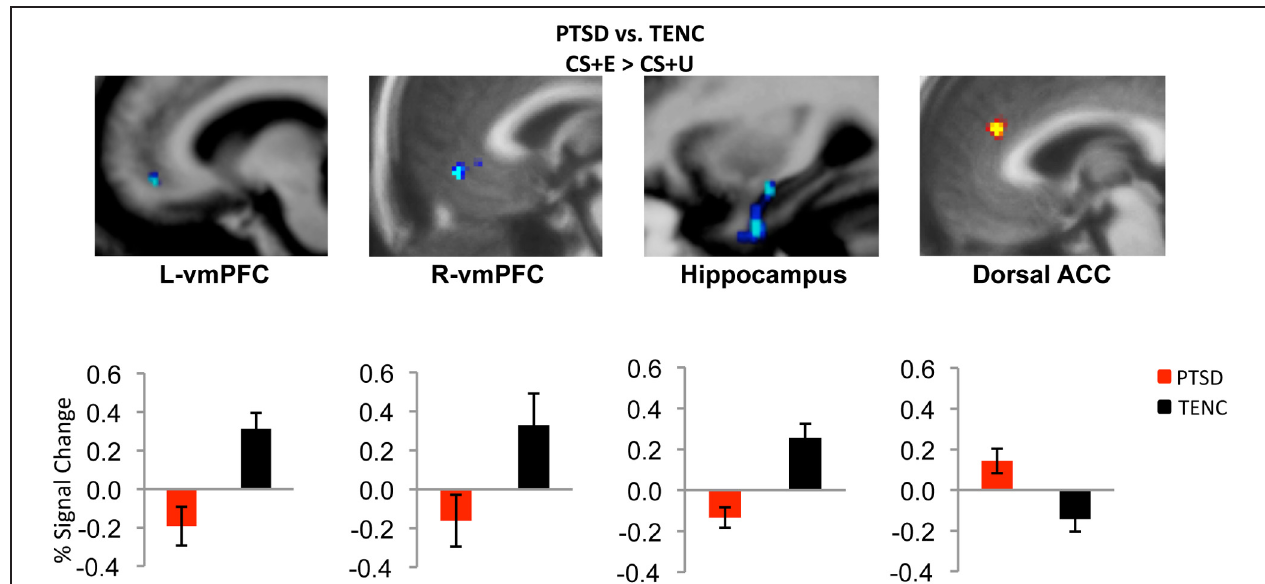
FIGURE 1 | Neural correlates of extinctionrecall inPTSD. During early extinction recall, participants with PTSD showed hypoactivation in bilateral ventromedial prefrontal cortex (vmPFC) and hippocampus and hyperactivation in dorsal anterior cingulate cortex (ACC) relative to the trauma-exposed normal control (TENC) group. CS + E = stimulus that was extinguished; CS + U = stimulus that was not extinguished. Adapted with permission from Figure 3; Milad et al. (2009).